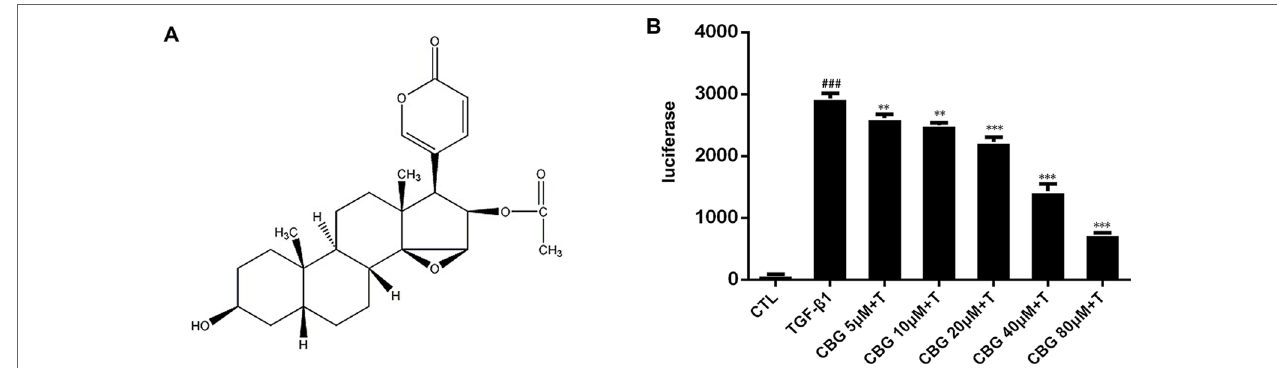
FIGURE 1 | Cinobufagin inhibits TGF- β 1/Smad3 signaling in fibroblasts. (A) Chemical structure of cinobufagin. (B) Cinobufagin antagonized TGF- β 1-induced reporter activity in a dose-dependent manner. As described in the Materials and methods section, CAGA-NIH3T3 cells were incubated with TGF- β 1 (5 ng·ml −1 ) with/without different doses of cinobufagin and then analyzed using a luciferase assay (n = 3 per group). Experiments were performed in triplicate, and statistical significance was obtained by one-way ANOVA. #represents a comparison with the blank control group, * represents a comparison with the TGF- β 1 group. # P < 0.05; ## P < 0.01; ### P < 0.001; P < 0.05; **P < 0.01; ***P <